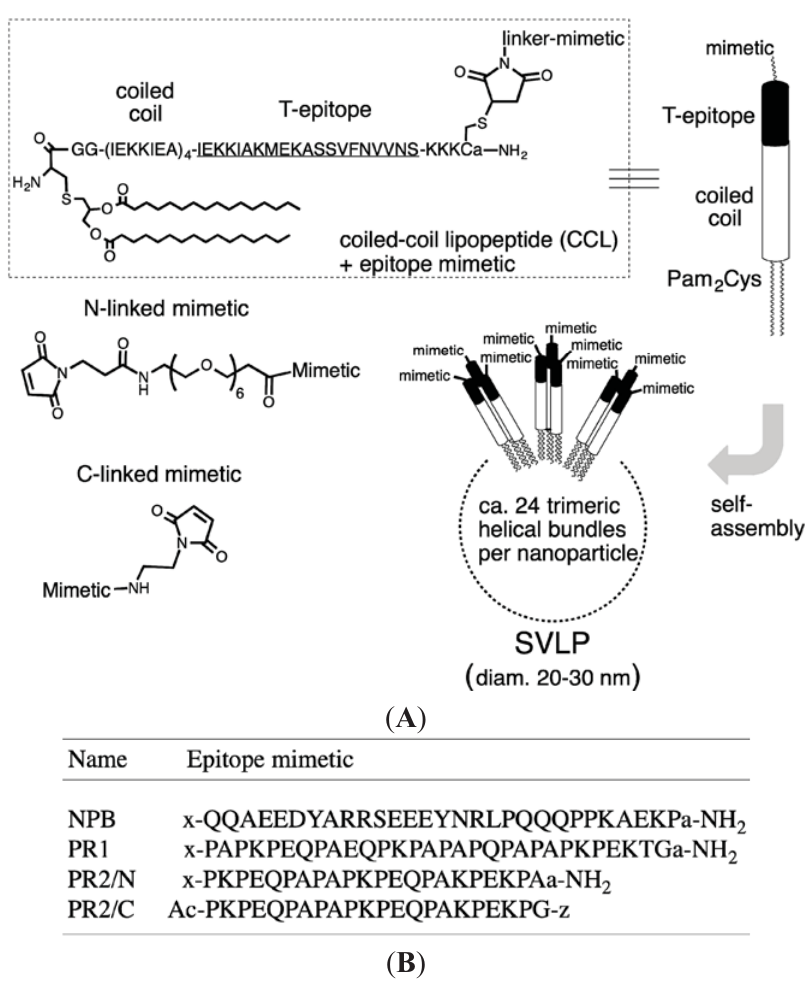
Figure 1. Components and their self-assembly into SVLPs. ( A ), SVLPs are composed of a synthetic coiled-coil lipopeptide (CCL), which contains a heptad repeat (IEKKIEA) 4 linked to a promiscuous T helper epitope (underlined) and to the TLR-2/6 ligand Pam 2 Cys. B-cell epitope mimetics can be conjugated to the unique Cys, as shown. The C-terminal